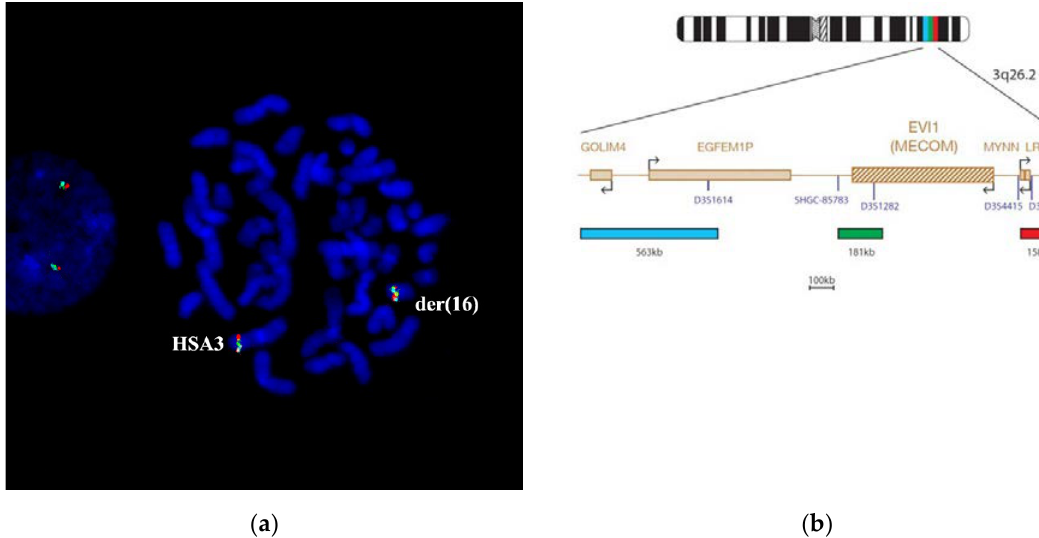
Figure 9. The analysis of 3q26.2 chromosomal segment. ( a ) FISH EVI1 Breakapart Probe on the patient’s chromosomes. ( b ) Scheme of EVI1 Breakapart Probe homology. The EVI1 3q26.2 product consists of a 158 kb probe, labeled in red, telomeric to the D3S4415 marker and including the LRRC34 gene, a green probe covering a 181 kb region, including the entire EVI1 gene and flanking regions and a blue probe, which covers the 563 kb region centromeric to the EVI1 gene, including the D3S3364 marker. Signal was detected at chromosomes 3 and der(16). Chromatin DAPI staining is in blue.